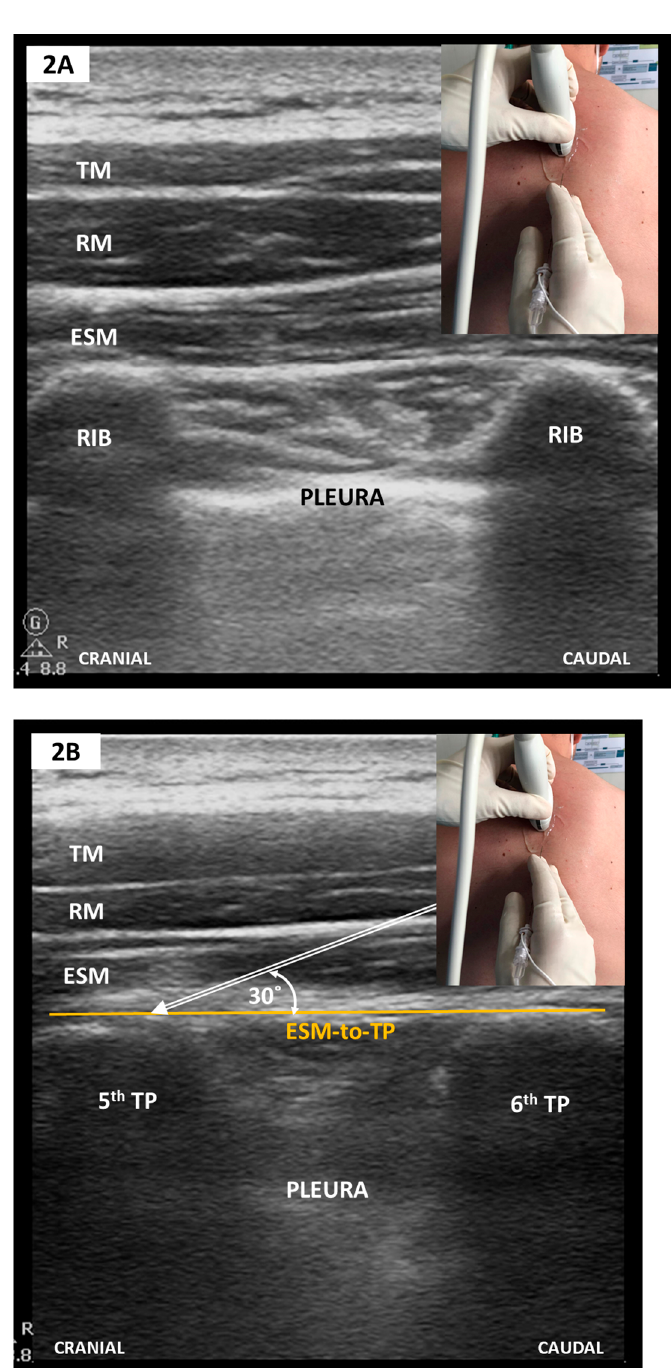
Figure 2. ( A ) . Parasagittal scan—rib level; ( B ) . Parasagittal scan—TP level (see text). TM, trapezius muscle; RM, rhomboid muscle; ESM, erector spinae muscle; TP, transverse vertebral process; ESM-to-TP, erector spinae muscle -to-transversus process